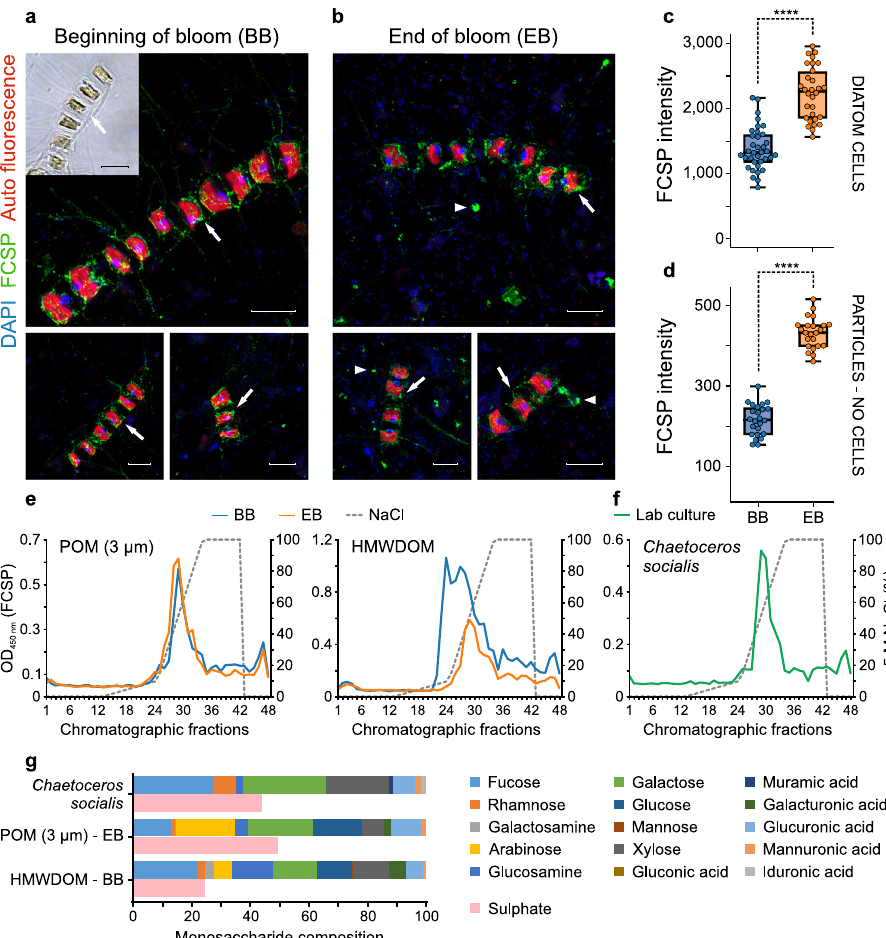
Fig. 2 Fucose-containing sulphated polysaccharide (FCSP) is produced by diatoms and increased abundance in particulate organic matter (POM) during the bloom. Inset in panel a , bright- fi eld image of Chaetoceros socialis cells. a , b Representative images of FCSP localisation in POM (>0.2 µ m) from the diatom bloom. Airyscan super-resolution images demonstrate FCSP occurred around the cells (arrows) of the chain-forming diatom C. socialis at the beginning of the bloom (BB) ( a ) and on the diatoms cells (arrows) as well as on particles (arrowheads) at the end of the bloom (EB) ( b ). In a , b , DAPI (blue), FCSP (green) and diatom auto fl uorescence (red). Scale bars, 10 µ m. Experiments were performed four times with similar results. c Quanti fi cation of FCSP signal (mAb BAM1) on diatom cells. BB n = 36 cells, EB n = 30 cells. d FCSP quanti fi cation on particles (areas not containing cells). BB n = 24 areas, EB n = 23 areas. In c , d **** P < 0.0001 (two-sided t -test), in c P = 8.4 × 10 − 13 and in d P = 2.3 × 10 − 23 . For boxplots, the middle line indicates the median, the box designates the interquartile range (IQR) and the whiskers denote 1.5 times the IQR. e , f Chromatographic separation of FCSP in water extracts from POM and high molecular weight dissolved organic matter (HMWDOM) of beginning and end of the bloom ( e ) and from a lab culture of the diatom C. socialis ( f ) by anion exchange chromatography (AEC). AEC fractions were analysed by ELISA with the mAb BAM1. ELISA developing time was not the same for the fi ve shown representative single FCSP separation AEC runs (four in e and one in f ), thus absorbance values do not indicate extract concentration (see Methods section). Optical density (OD). Experiments (chromatography plus ELISA analyses) for BB and EB POM were performed two times per each, for BB and EB HMWDOM four times per each and for C. socialis four times, with similar results. g Monosaccharide composition of puri fi ed FCSP (AEC fraction with BAM1 absorbance peak) as mean relative abundance, n = 2 independent acid hydrolysis and HPAEC-PAD runs. See FCSP monosaccharide composition of additional AEC fractions in Supplementary Fig. 6b. Sulphate content ( n = 2 technical replicates) of each puri fi ed FCSP sample as µ M sulphate per µ M total building